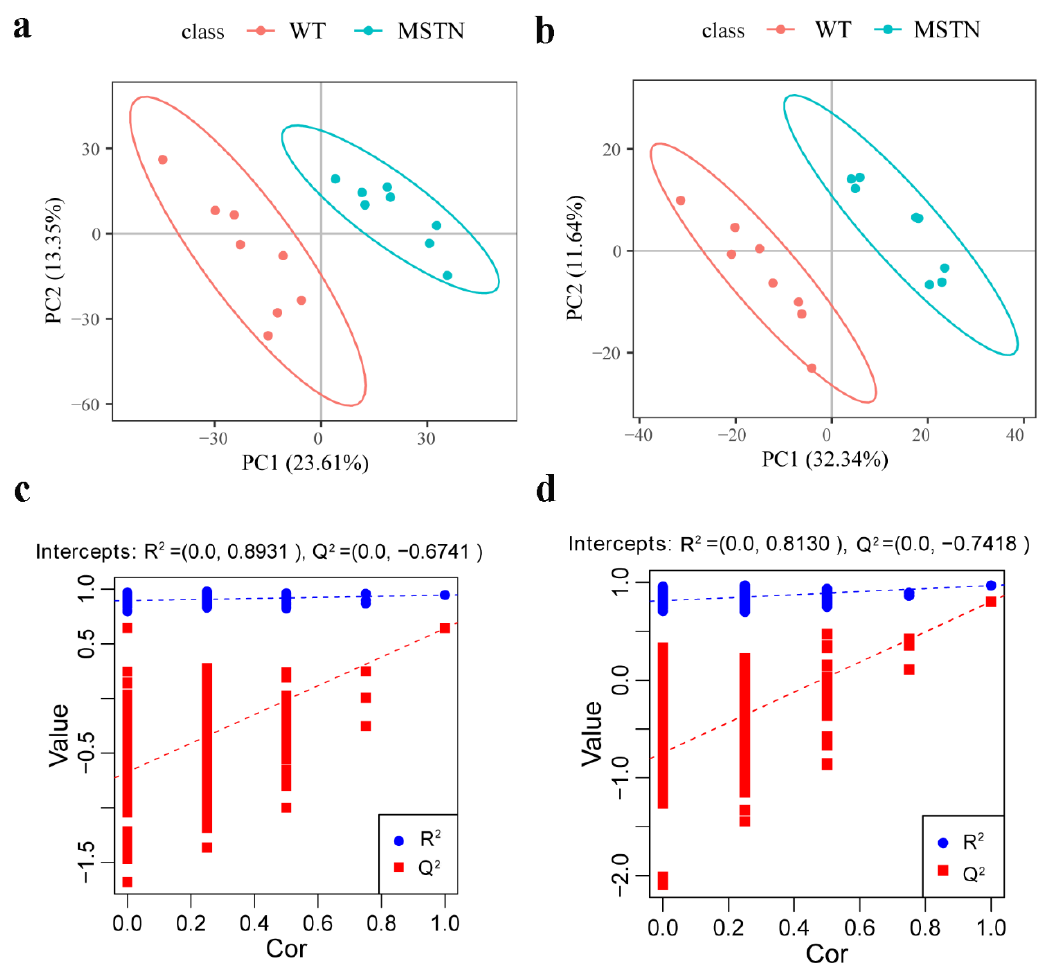
Figure 3. PLS-DA of lipid metabolite profiling data for comparison of MSTN +/− and WT pigs. ( a ) PLS-DA score plots of WT and MSTN -edited pigs based on the extracted spectral data in positive ion mode; ( b ) PLS-DA score plots of WT and MSTN -edited pigs based on extracted spectral data in negative ion mode; ( c ) Permutation plot of PLS-DA based on the extracted spectral data in positive ion mode. R 2 Y = 0.8931 and Q 2 = 0.6741; ( d ) Permutation plot of PLS-DA based on the extracted spectral data in negative ion mode. R 2 Y = 0.8130 and Q 2 =